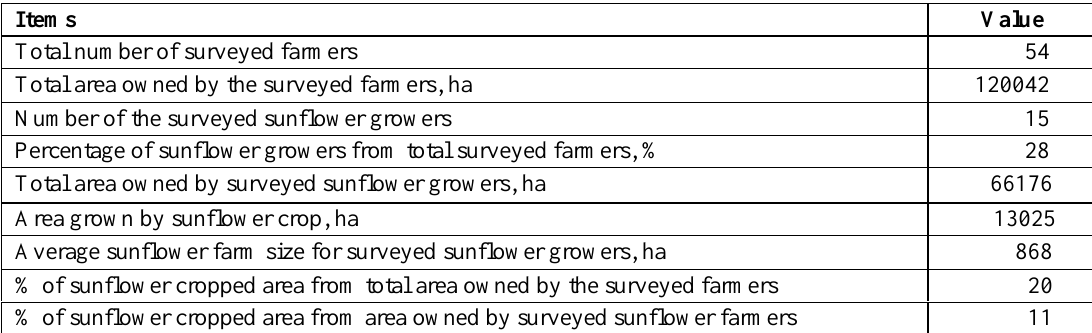
rain fed schemes in eastern Sudan